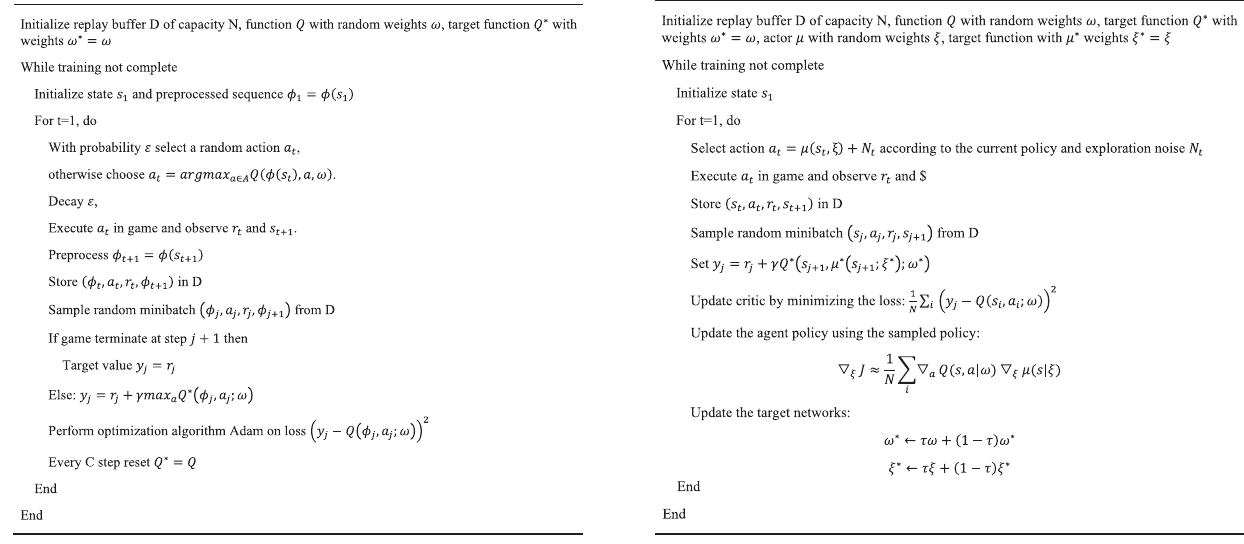
Algorithm 1. Deep Q-learning Network. Algorithm 2. Deep Deterministic Policy Gradient